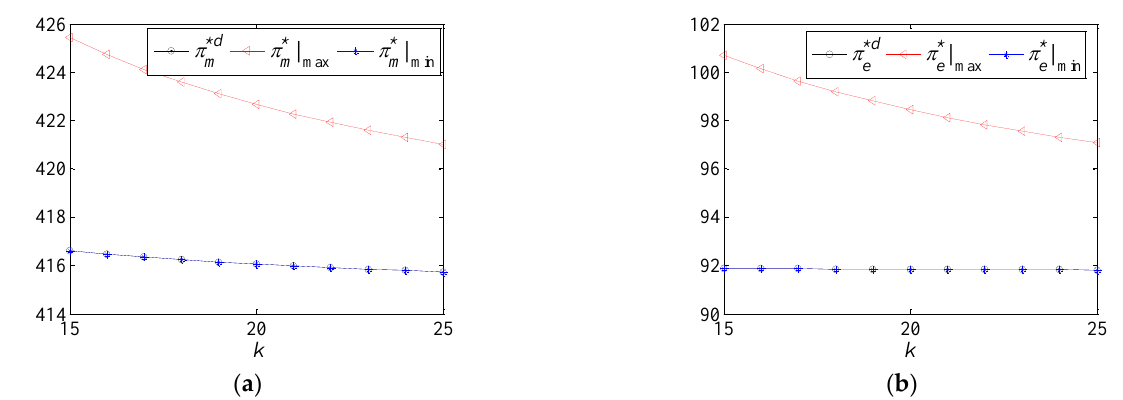
∗ m and π e . ( a ) Coordination results of π